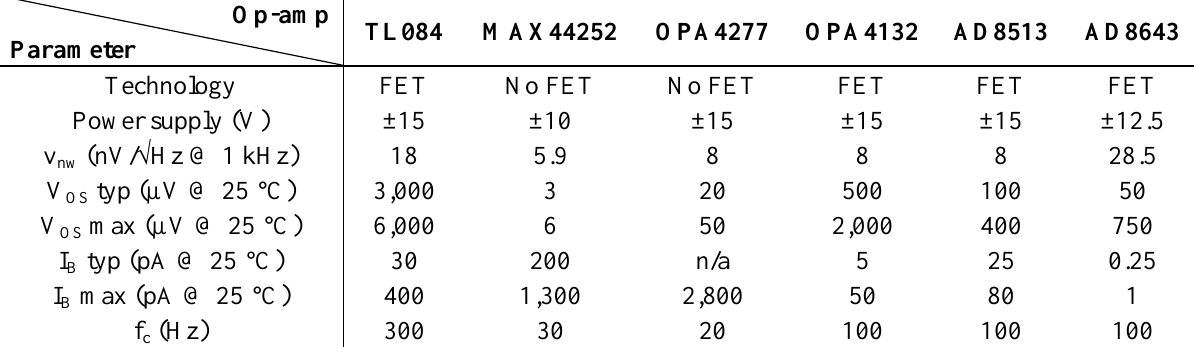
node in the test circuit in Figure 5 for the hpf